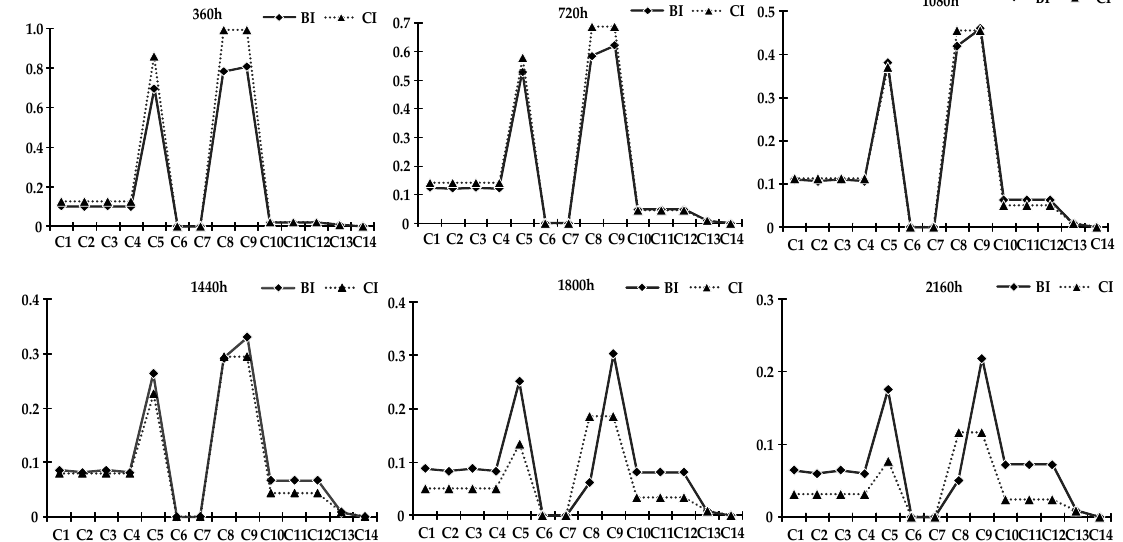
Figure 7. BI and CI values for components at different operational time when P N is larger than P out .